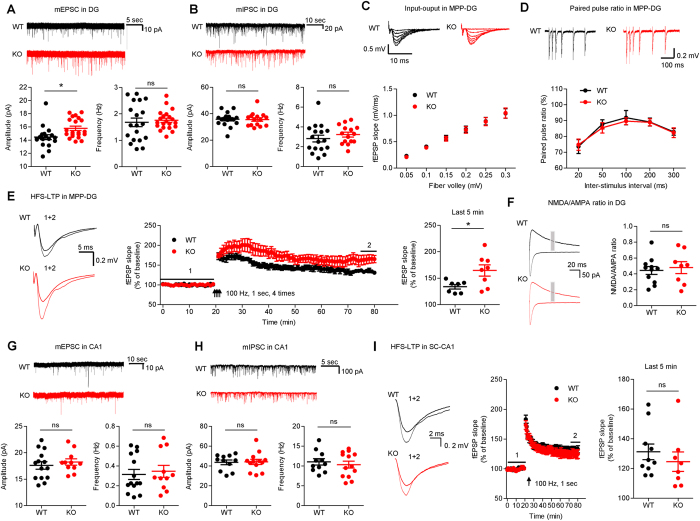
Enhanced LTP in the DG, but not CA1, region of the Dorfin−/− hippocampus.(A) Increased amplitude, but normal frequency, of mEPSCs in Dorfin−/− DG granule cells (P15–17, s.e.m., n = 19 cells from 5 mice for WT and 21, 3 for KO, *p < 0.05, ns, not significant, Student’s t-test). (B) Normal frequency and amplitude of mIPSCs in Dorfin−/− DG granule cells (P15–17, s.e.m., n = 17, 4 for WT and 15, 4 for KO, ns, not significant, Student’s t-test). (C) Normal input-output curve, determined by plotting field EPSP (fEPSP) slopes against fiber volley amplitudes at Dorfin−/− MPP-DG synapses (3 weeks, n = 11 slices from 4 mice for WT and 13, 4 for KO). (D) Normal paired pulse ratio, determined by plotting the ratios of two consecutive fEPSP slopes against inter-stimulus intervals at Dorfin−/− MPP-DG synapses (3 weeks, n = 11 slices from 4 WT mice and 13, 4 for KO). (E) Enhanced LTP induced by four trains of HFS at Dorfin−/− MPP-DG synapses (4 weeks, s.e.m., n = 7 slices from 4 mice for WT and 8, 7 for KO, *p < 0.05, Student’s t-test). (F) Normal NMDA/AMPA ratio at Dorfin−/− MPP-DG synapses, determined by comparing evoked fEPSP slopes at the holding potentials of −70 (AMPA) and +40 (NMDA) mV (3 weeks, s.e.m., n = 11 cells from 6 mice for WT and 8, 4 for KO, ns, not significant, Student’s t-test). (G) Normal frequency and amplitude of mEPSCs in Dorfin−/− CA1 pyramidal cells (P15–17, s.e.m., n = 14 cells from 3 mice for WT and 11, 3 for KO, ns, not significant, Student’s t-test). (H) Normal frequency and amplitude of mIPSCs in Dorfin−/− CA1 pyramidal cells (P15–20, s.e.m., n = 11, 3 for WT and 13, 4 for KO, ns, not significant, Student’s t-test). (J) Normal LTP induced by HFS at Dorfin−/− SC-CA1 synapses (4 weeks, n = 10 slices from 6 mice for WT and 8, 5 for KO, ns, not significant, Student’s t-test).